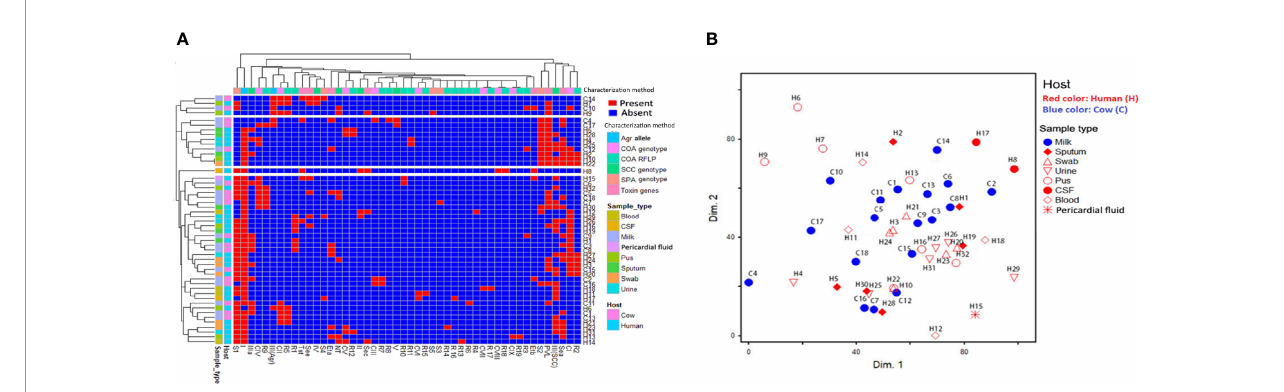
FIGURE 4 | Distribution and hierarchical clustering of ST239-MRSA strains and the different genotypes based on different molecular typing methods. (A) Heatmap showing the occurrence of particular genotype/toxin gene in the studied ST239-MRSA strains. Red and blue colors refer to presence and absence of a particular feature, respectively. The dendrogram represents the hierarchical clustering of the strains and the genotype variables. Different categories of genotyping methods, sample types, and hosts are color-coded on the right of the heatmap. (B) Non-metric multidimensional scaling analysis indicating the presence of each subject in the 2-dimensional space and thus showing how the subjects could cluster or be separated from each other. CI – CIX, coagulase genotypes; R1 – R19, coa -RFLP patterns; SCC mec ( II , III , IV , and V ), staphylococcal cassette chromosome mec ; NT, non-typeable; agr ( I and III ), accessory gene regulator; S1 – S5, spa PCR products; van , vancomycin resistance gene; pvl , Panton – Valentine leucocidin; sea , see , and sec , staphylococcal enterotoxins A, B, and C; tst , toxic shock syndrome toxin; eta and etb , exfoliative toxins A and